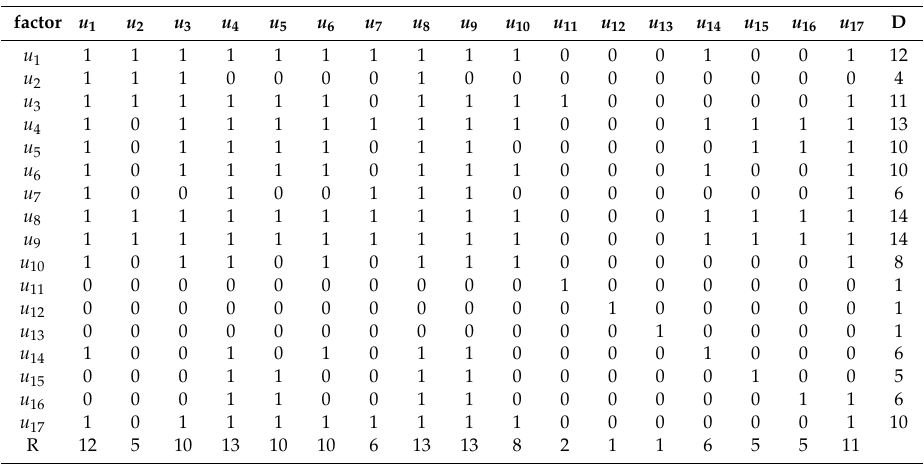
Table 3. Reachability matrix F of vulnerability